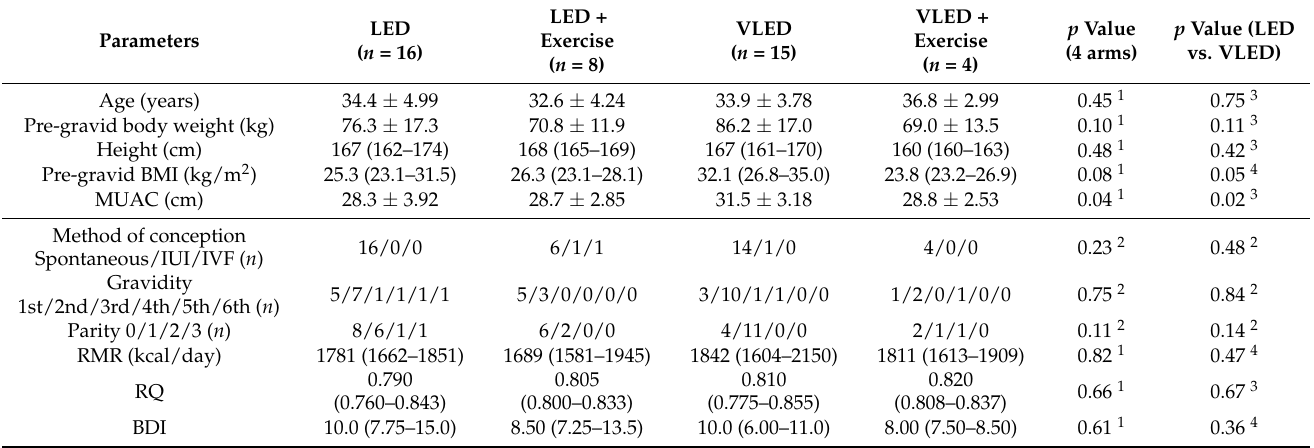
Table 1. Participant characteristics at baseline (mean ± SD, median and IQR, or n